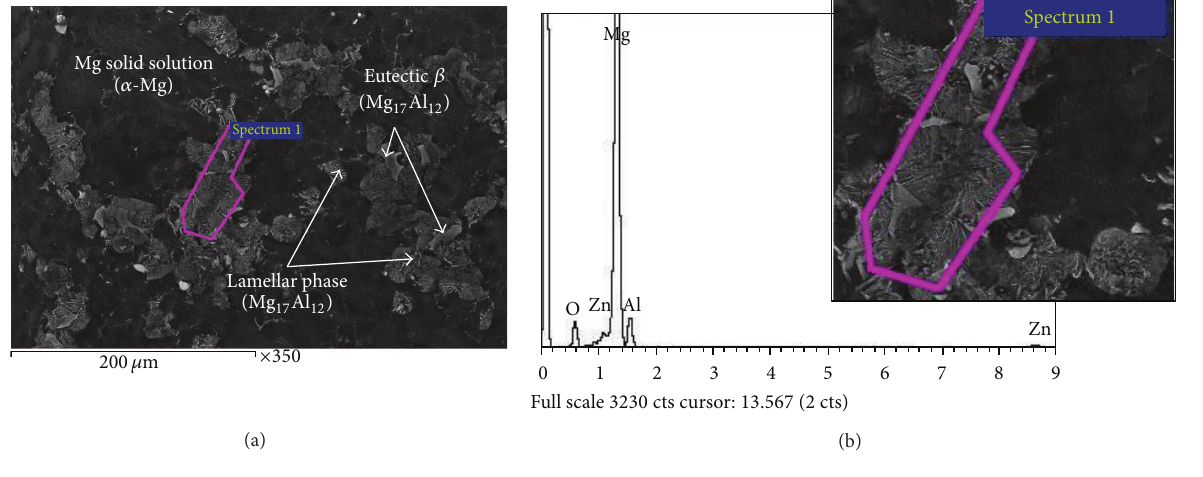
Figure 1: SEM micrograph (a) and EDS (b) of un-heat-treated AZ61 Mg-alloy.